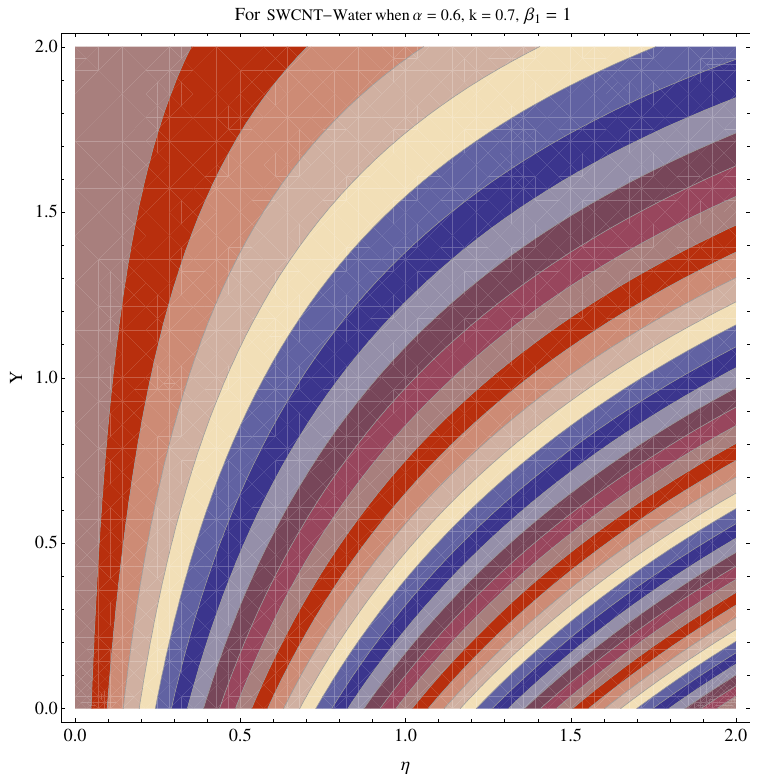
Figure 17. Contour graph at β 1 = 1.0 for SWCNT at larger k .